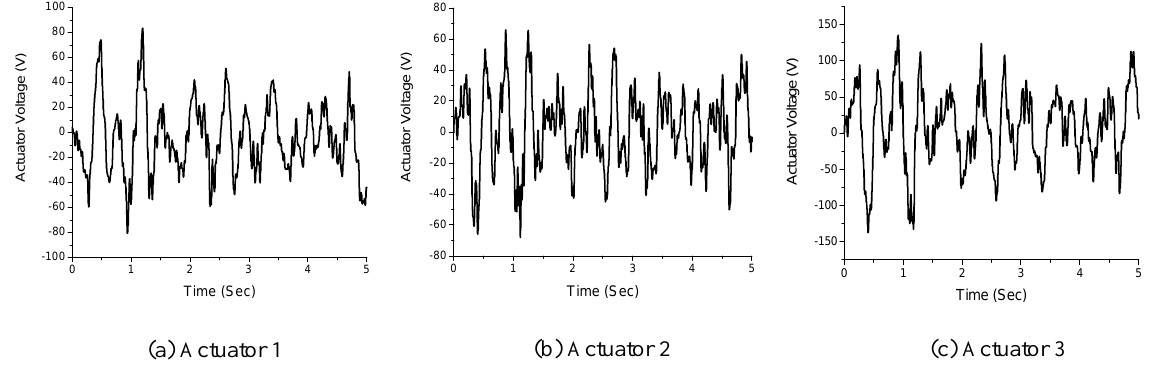
Fig. 9. Time history of actuator voltage for case